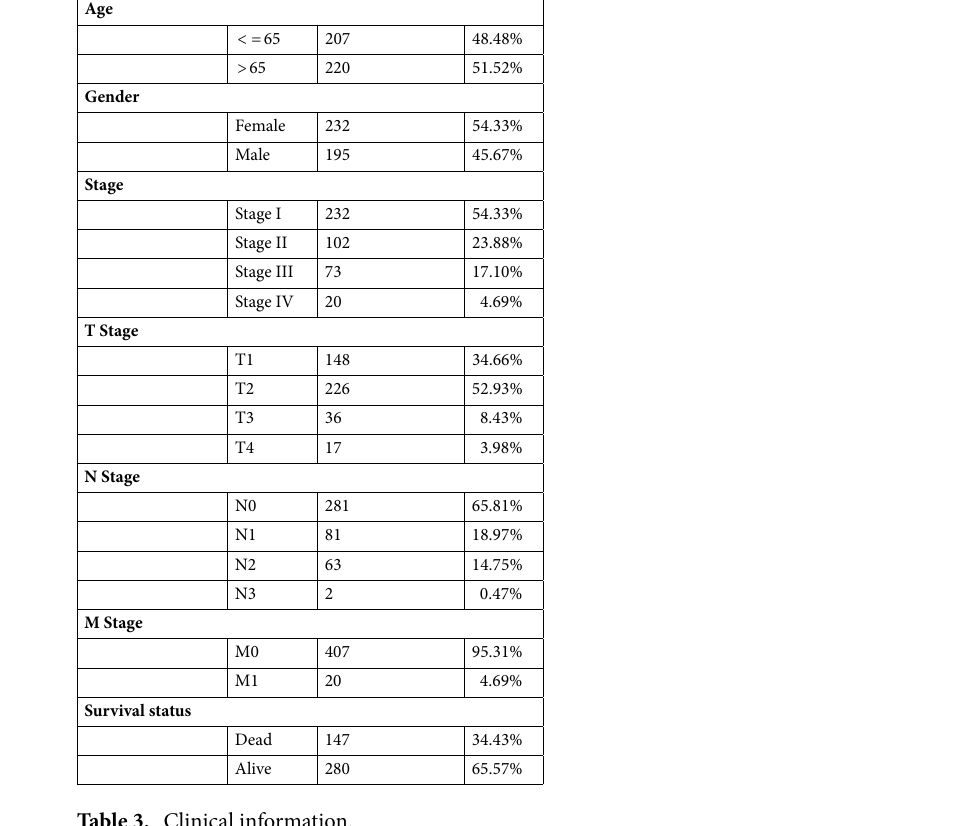
Table 3. Clinical